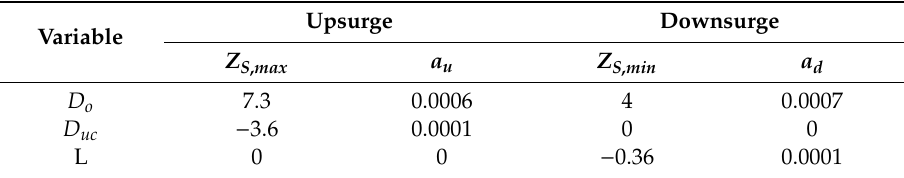
Table 3. Sensitivity: slope of sensitivity